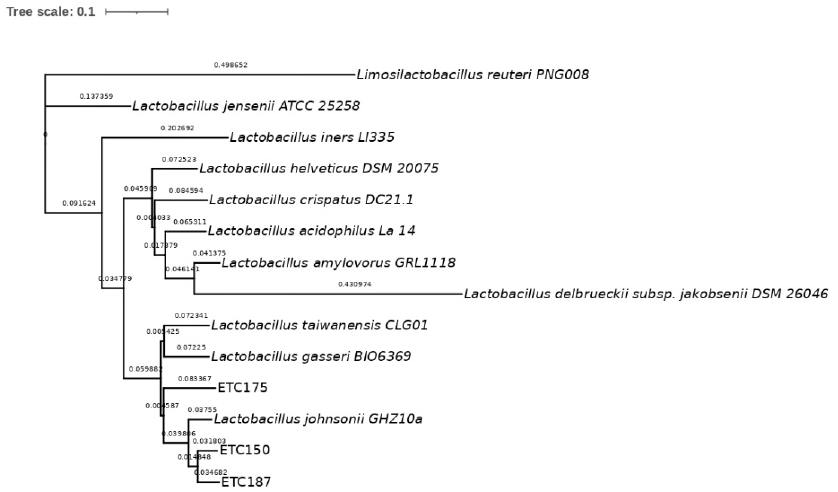
Figure 3. Maximum-likelihood tree with tuf gene sequences. Bar, 10% nucleotide substitutions.